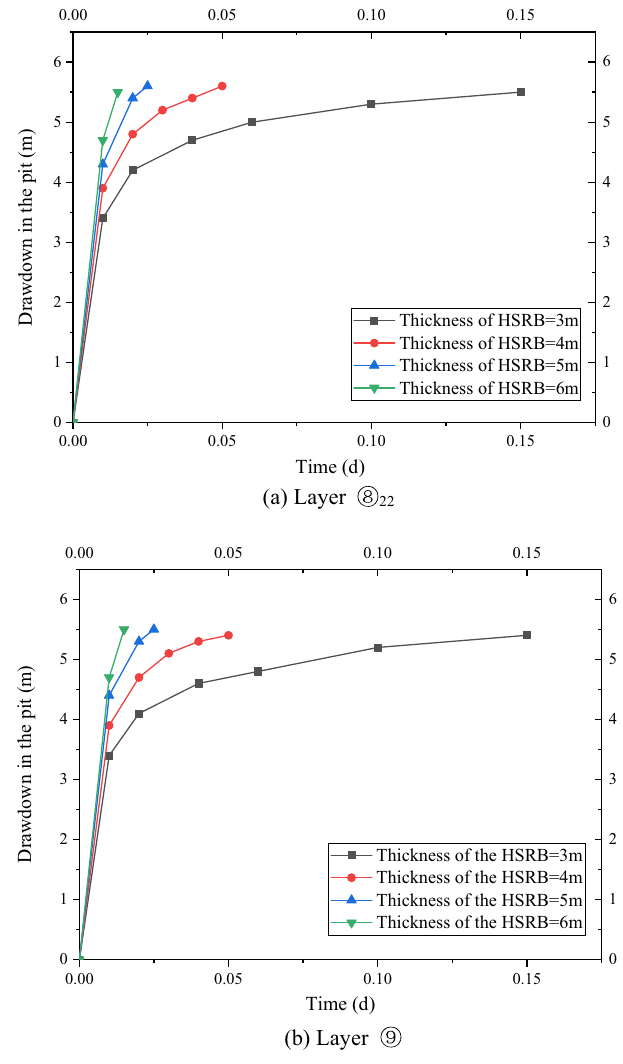
Figure 11. Drawdown–time curve in the pit with different HSRB